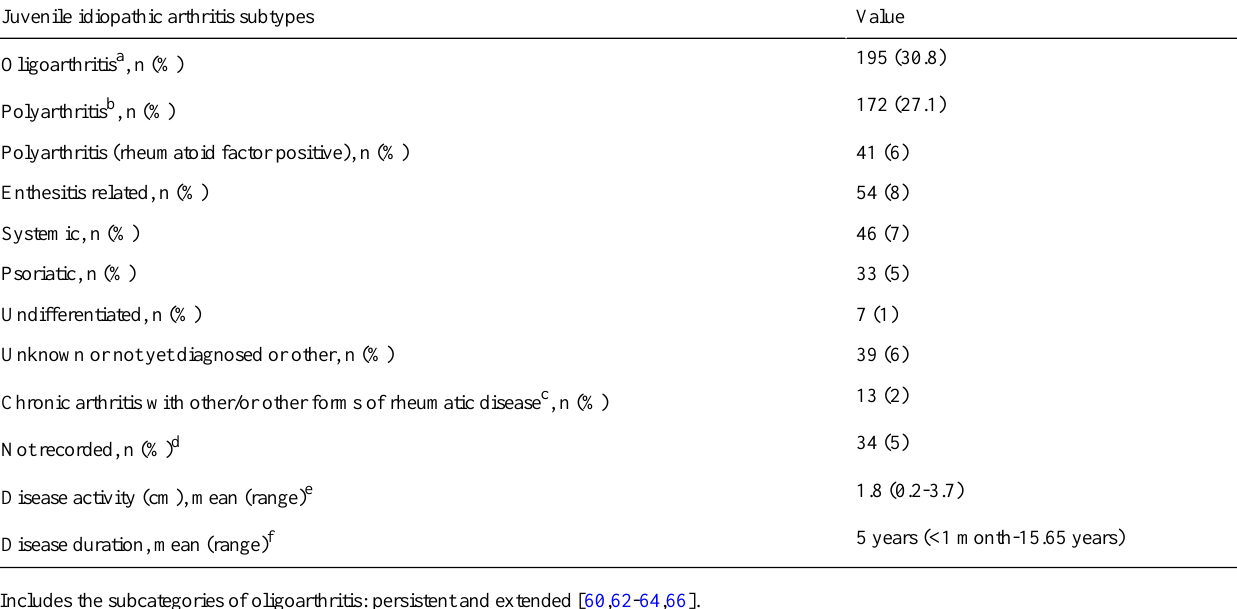
Table 1. Juvenile idiopathic arthritis subtypes, based on the International League of Associations for Rheumatology criteria. ValueJuvenile idiopathic arthritis